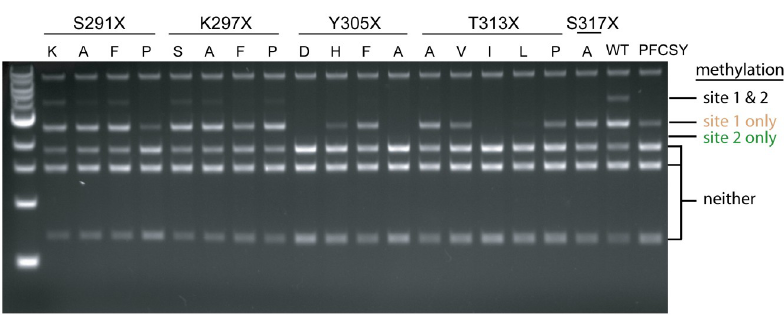
Fig 6. Methylation of dCas9-MC/MN and associated variants as assessed by FspI restriction protection assay. sgRNA1 was used to target methylation to site 1. Methylation was assayed from plasmid DNA extracted from ER2267 cells expressing the dCas9-MC/MN (WT) or the indicated dCas9-MC/MN variant. The first row indicates the position mutated, and the second row indicates the mutation made. The PFCSY set of mutations is in the final lane.